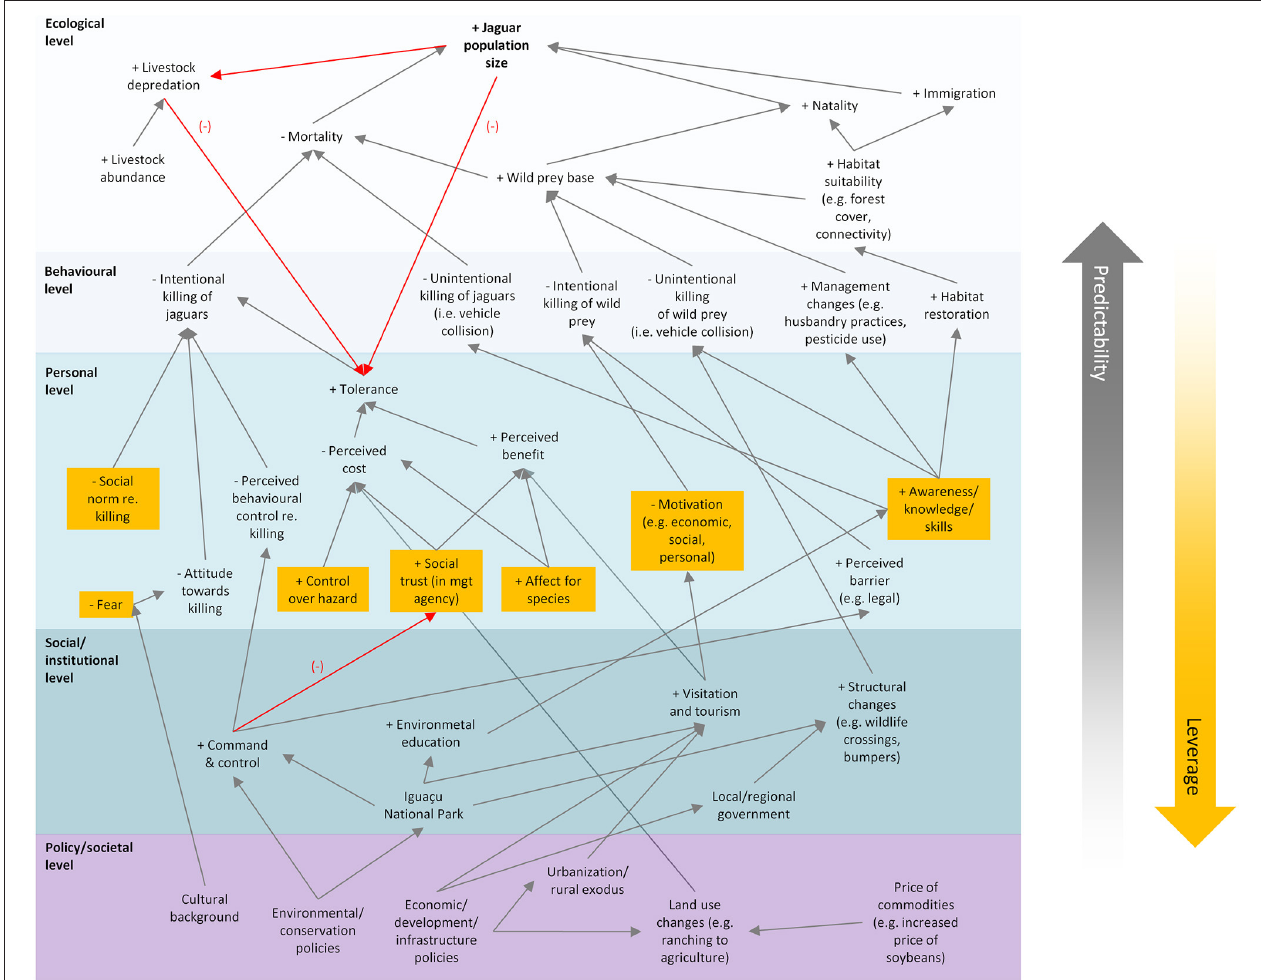
FIGURE 2 | System map of the determinants of change in jaguar population size in Iguaçu National Park, Brazil. The map was produced by the Jaguars of Iguaçu Project team in a workshop on planning for coexistence. The levels of analysis are ecological, (human) behavioral, personal, social/institutional, and policy/societal. Arrows depict causal relationships; red arrows are unintended effects or feedback loops. Leverage points for Jaguars of Iguaçu Project are highlighted in orange. Effects on jaguar population size are more predictable toward more proximal levels of analysis, but leverage of actions is greater toward more distal, fundamental